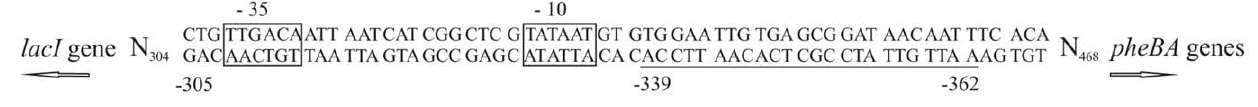
Figure 3. The location of the P tac promoter and the LacI operator sequence in the phe-lacI test system. 2 10 and 2 35 hexamers of the P tac promoter are boxed and the operator sequence is underlined. The nucleotide positions of the operator sequence are given from translational initiator codon GTG of the lacI gene.